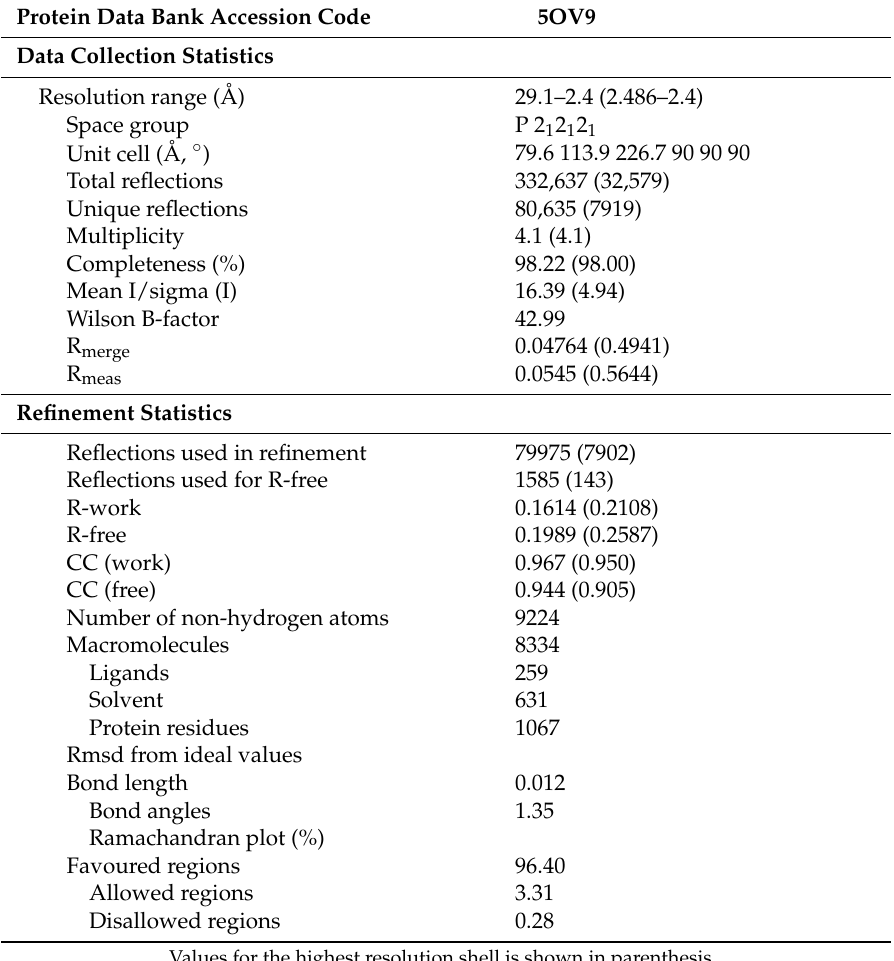
Table A1. Data collection and refinement